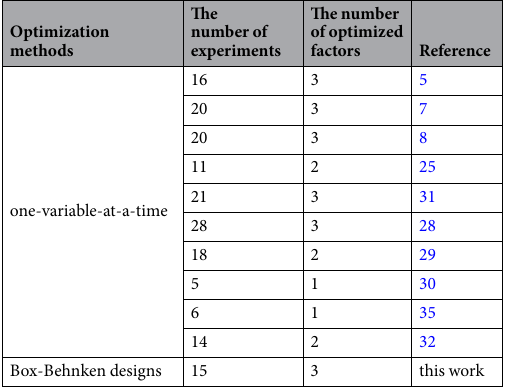
Table 3. Comparisons between one-variable-at-a-time and Box-Behnken designs in parameters optimization of DPASV for lead(II)